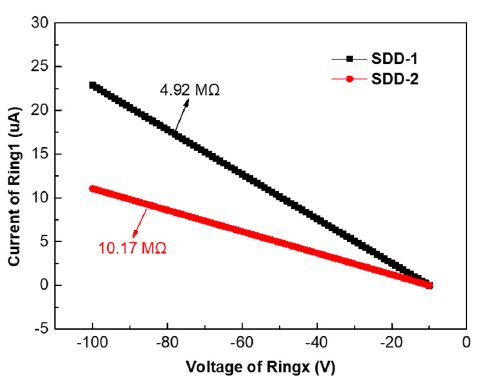
Figure 6. The IV characteristics of voltage dividers of SDD-1 and SDD-2.